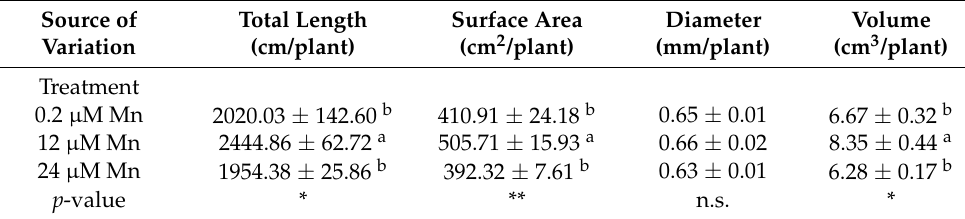
Table 1. Root morphological parameters of ‘Istarska bjelica’ olive cv. treated with three different manganese (Mn)